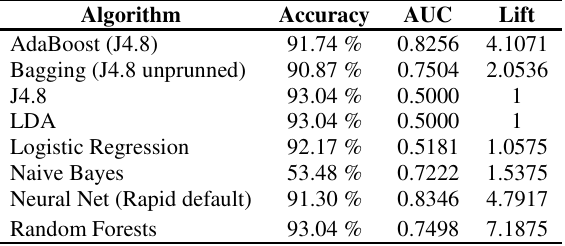
Table 2: Performance results of different classification algorithms for predicting student excellence on a course.